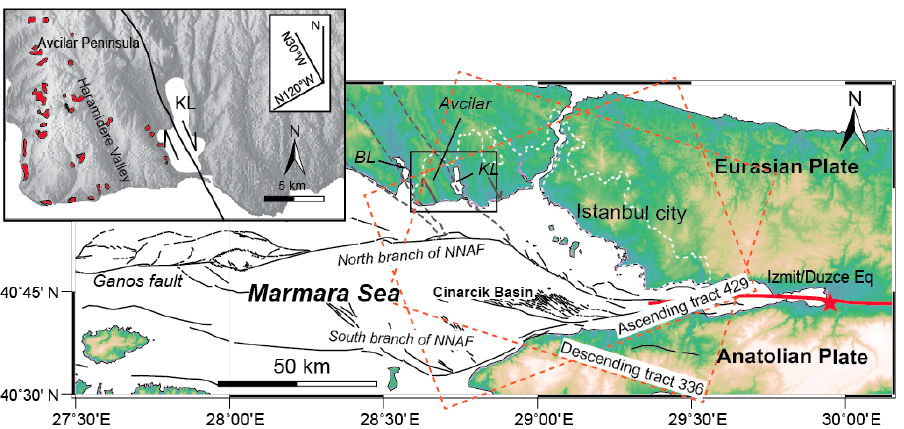
Figure 1. Geological map of the study area. The black lines indicate the distribution of active faults in this area [7], whereas the dashed gray lines show the trace of the secondary faults southwest of Istanbul [8]. The red line and red star show the coseismic rupture and epicenter of the İ zmit/Düzce earthquakes, respectively. The black box draws the study area of this paper. The dashed orange boxes show the spatial coverage of the ascending and descending track in this area. NNAF: Northern branch of the North Anatolian Fault; KL: Küçükçekmece Lake; BL: Büyükçekmece Lake. The upper left panel shows the shaded relief map of the study area, in which the isolate red areas show active landslides [9].